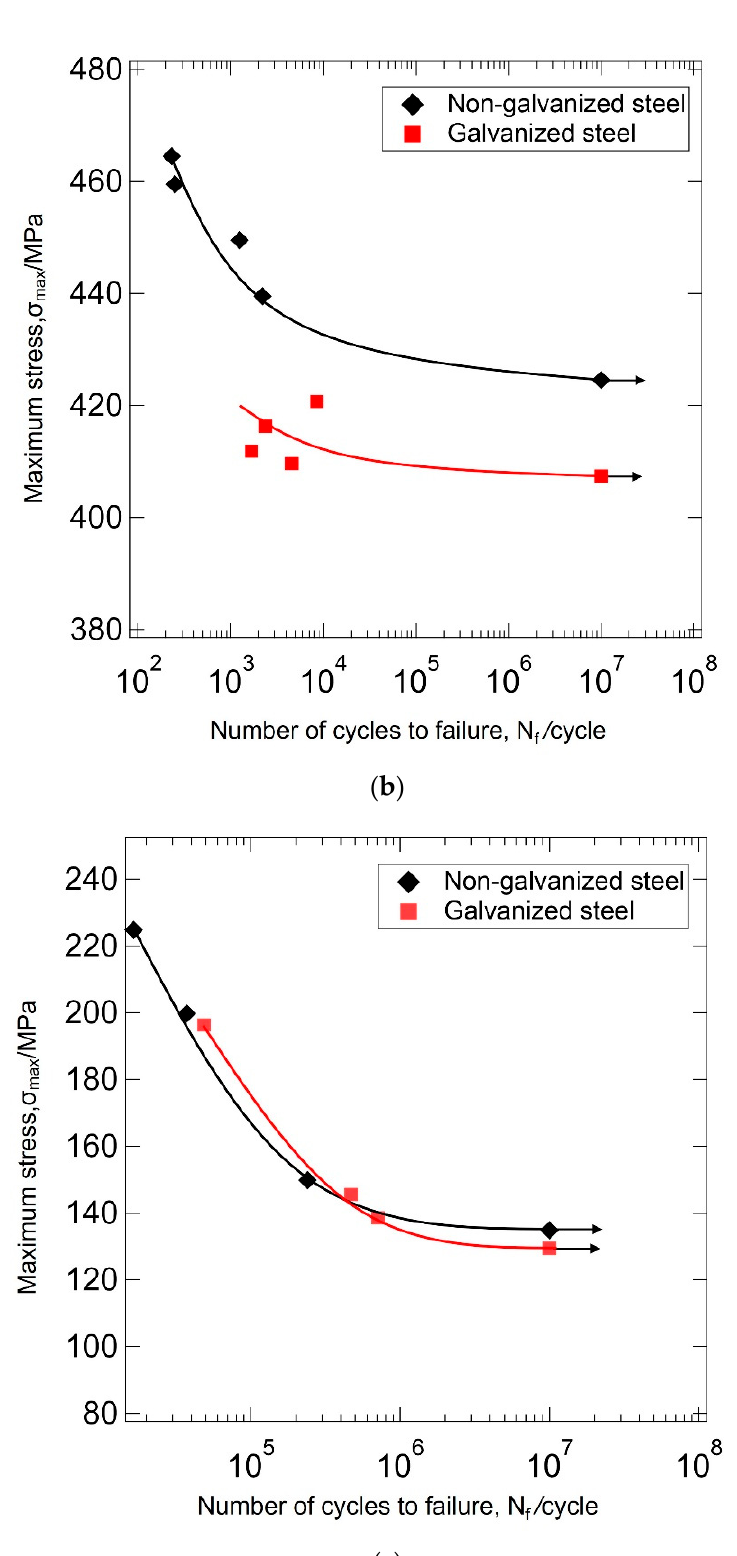
Figure 6. Fatigue strength at N f = 10 7 cycles for galvanized and non-galvanized AISI 1020 normalized steels under ( a ) R = 0.01, ( b ) R = 0.5, and ( c ) R = − 1.0. Arrows show that the specimen reached 10 7 cycles, and the test was stopped voluntarily.